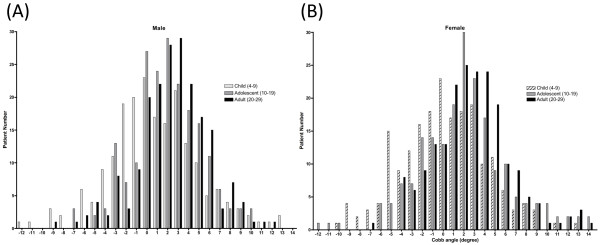
Extent of side curvature in the normal spine. The degree of the side curvature in children (ages 4-9), adolescents (ages 10-19), and adults (ages 20-29) is shown. Right-sided curvature is given a positive value. (A) shows male and (B) shows female.